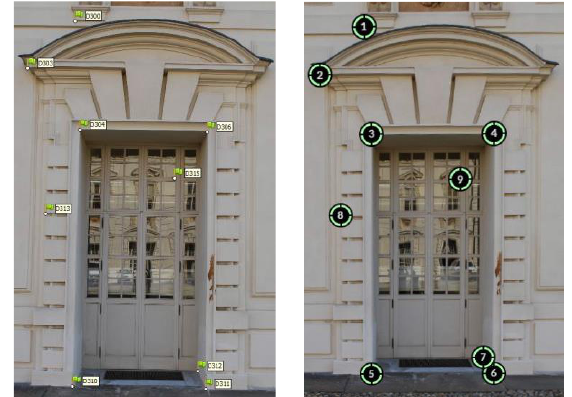
Figure 4 The employed GCPs in Photscan (left) and ReCap (right)